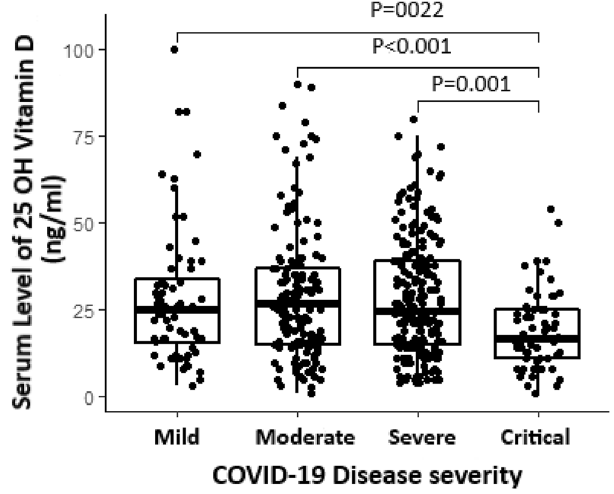
Figure 1. Comparative diagram of median and interquartile of serum 25 hydroxyvitamin D level in different intensities of COVID-19